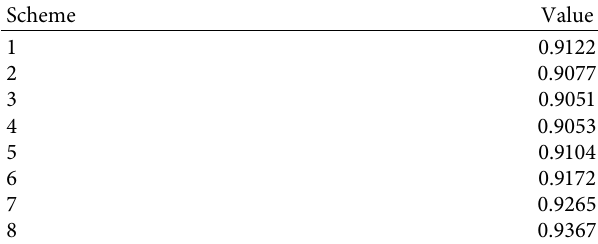
Table 9: The calculation results of method 2.